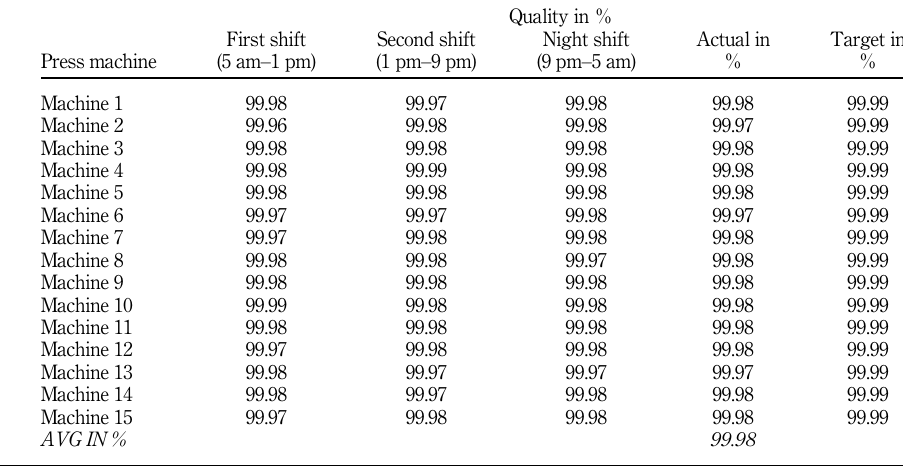
Table 4. Quality